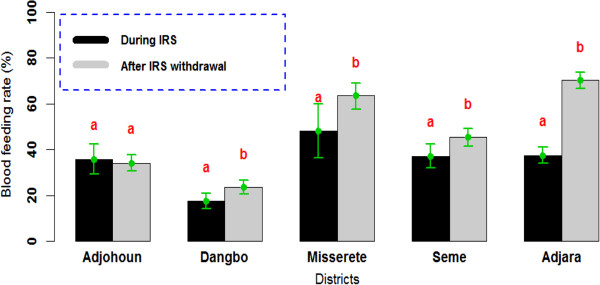
Blood feeding rate of Culicidae observed during IRS implementation and after IRS withdrawal. The rate carrying the same letter per district was not significantly different (p> 0.05).